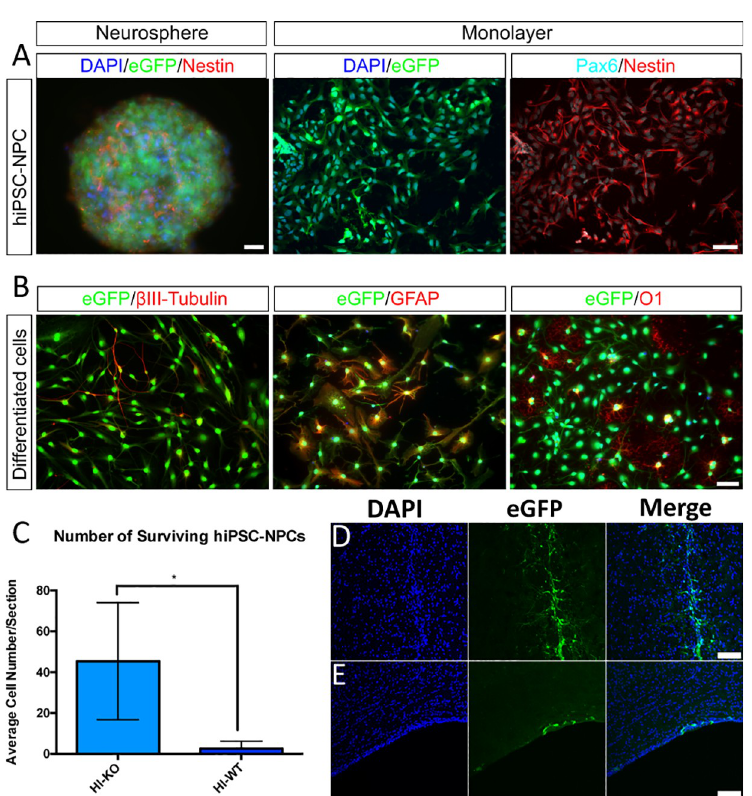
Fig 10. Increased survival of hiPSC-NPCs in KO injured animals. hiPSC-NPCs demonstrated the ability to form neurospheres (A left), express eGFP (A middle), and express the neural progenitor markers Nestin and Pax6 (A right). hiPSC-NPCs cultured under differentiation conditions expressed markers for neurons (B left), astrocytes (B middle), and oligodendrocytes (B right). Transplantation of these cells into the CPu of HI-injured animals resulted in significantly elevated cell survival in KO animals over WT animals at 10 weeks post-transplant (C). Representative images of eGFP-positive hiPSC-NPCs in KO injured (D) and WT injured (E) animals (blue = DAPI, green =